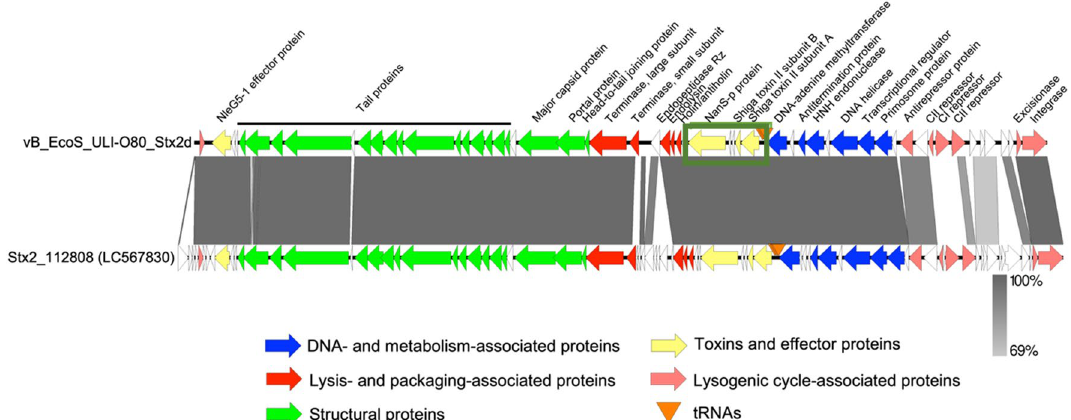
Figure 1. Comparative genomics of phage vB_EcoS_ULI-O80_Stx2d and Stx2_112808. Each arrow represents a coding sequence. In red, genes coding packaging and lysis-associated proteins are displayed; in green, structural proteins; in blue, DNA and metabolism-associated proteins; in pink, lysogenic-associated proteins. The stx region is highlighted in a box with toxins and effectors proteins like the two Shiga toxin II subunit A and B and the the nanS-p gene represented in yellow.